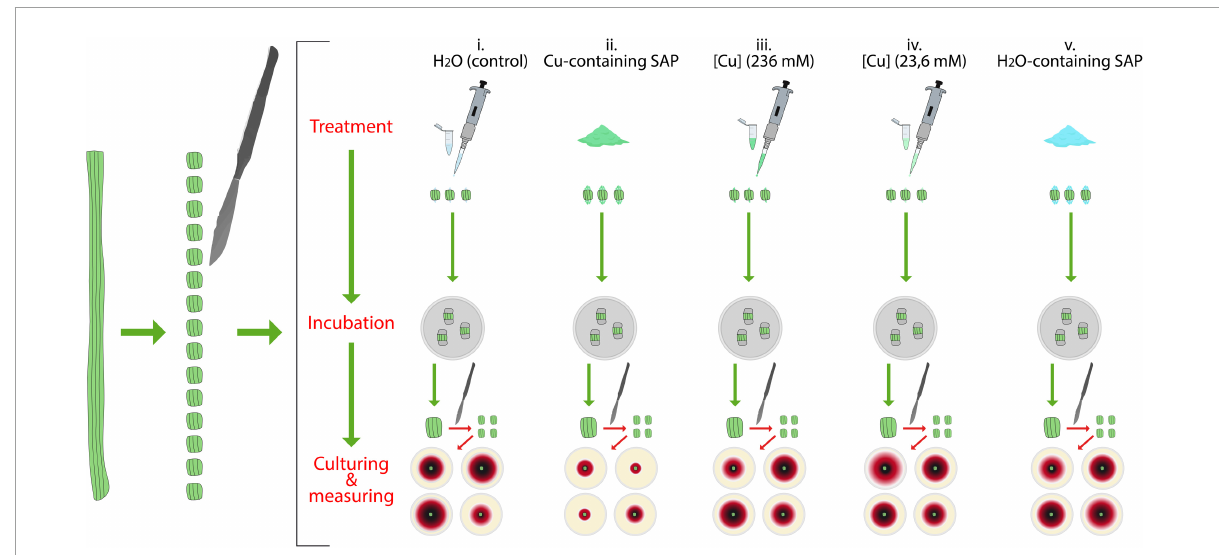
FIGURE2 Schematic representation of the test for the evaluation of the capacity of super absorbent polymer containing copper (SAP-Cu) to inhibit Plenodomus tracheiphilus growth in naturally infected twigs.